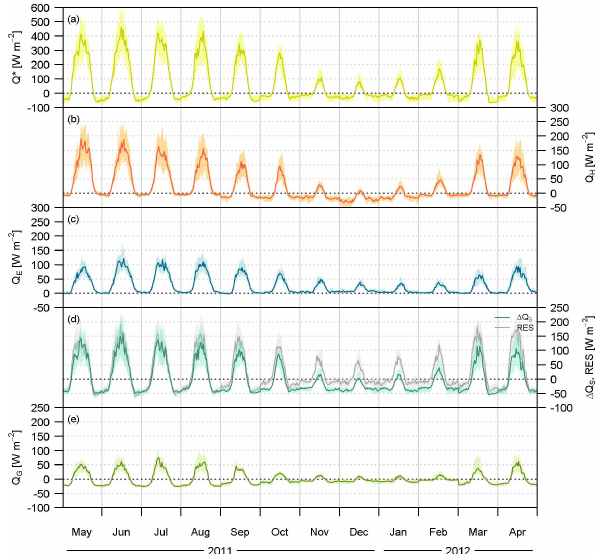
Fig. 5. Median diurnal cycles (lines) and interquartile ranges (shading) of the energy fluxes for the study